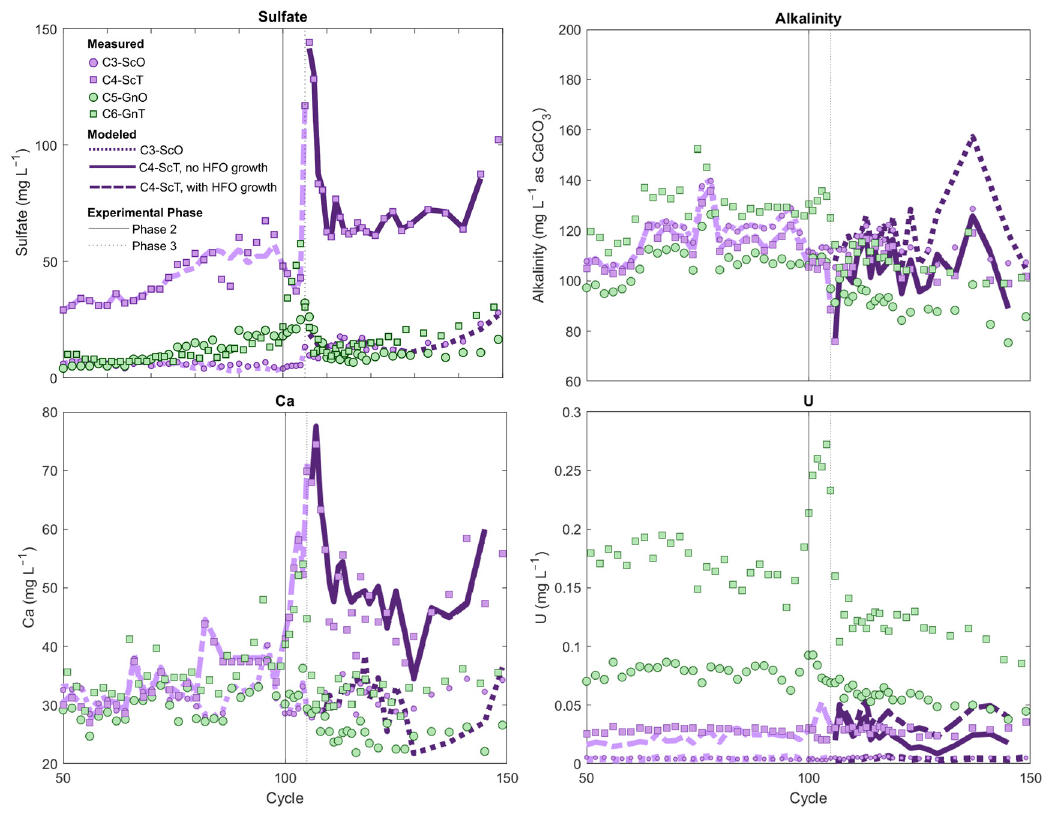
Figure 7. Column leachate composition during the sequencing experiments for transition (square symbols) and oxide (circular symbols) gneiss and schist columns. Sequencing experiments are described in Supplementary Table S1. Lines represent modeled concentrations: dotted lines = schist-oxide model; solid lines = schist-transition model with hydrous ferric oxides (HFO) growth; dashed line = schist-transition model with a fixed HFO composition. Light and dark line colors differentiate Phase 1 and Phase 3 model outputs.